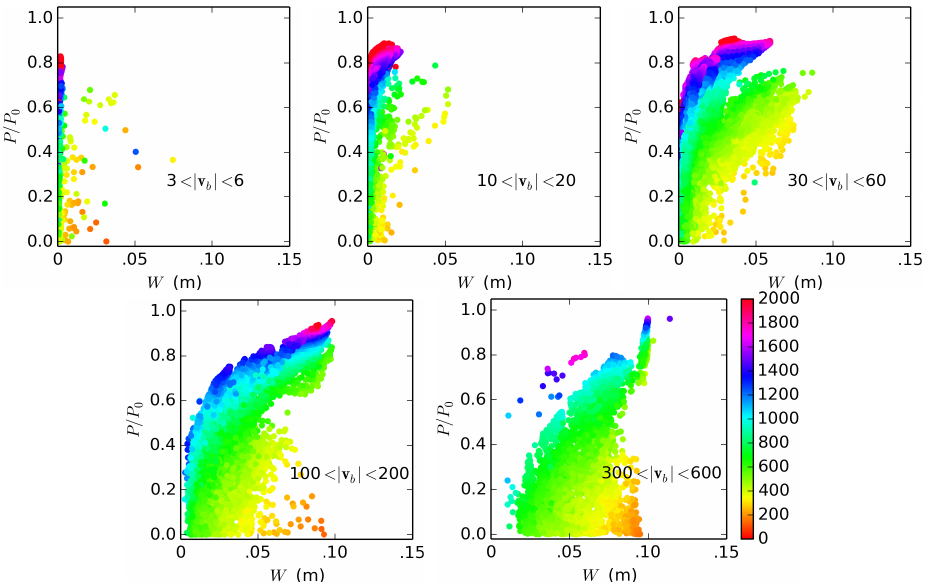
Figure 10. Scatter plots of (W,P/P o ) pairs for all cells from the distributed model run, which used roughness scale W r = 0 . 1m. Each sub-plot only shows pairs from the indicated range of ice sliding speeds. Points are colored by ice thickness using a common scale shown beside last